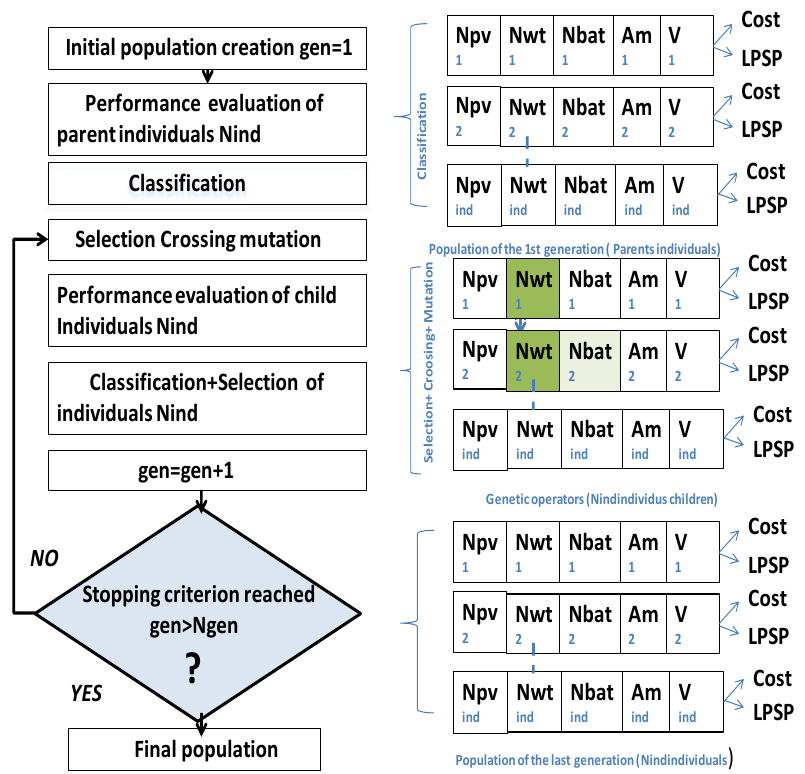
Table 3. Parameters regulation for NSGAII.